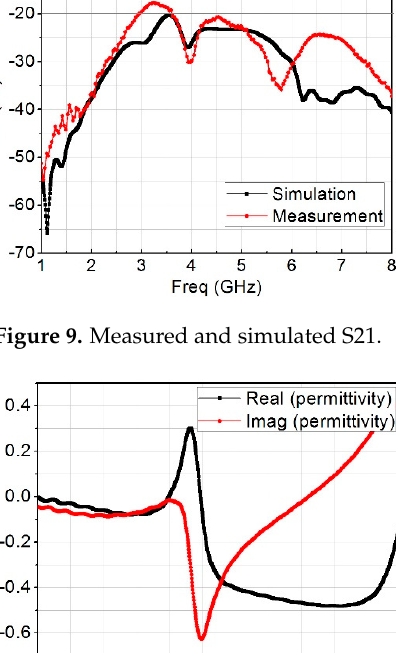
Figure 8. Measured and simulated VSWR.